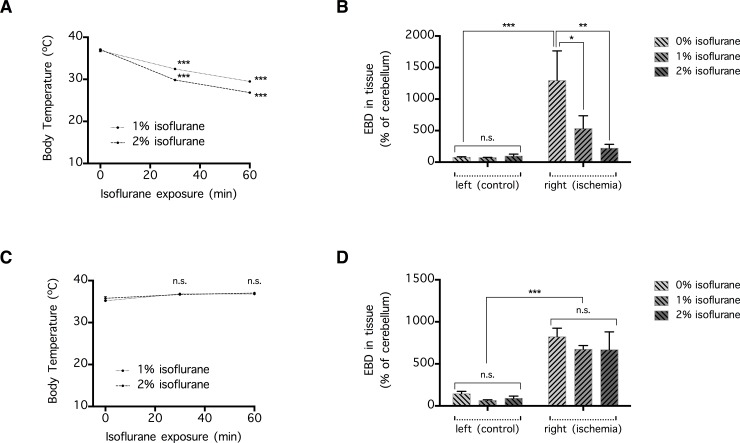
Hypothermic but not normothermic isoflurane-anesthesia attenuates early blood-brain barrier (BBB) disruption following distal middle cerebral arterial occlusion (dMCAo).(A) Body temperature was measured continuously in mice using a rectal probe, and recorded at 0, 30, and 60 min after exposure to 1% or 2% isoflurane (n = 5 per group). Data are expressed as mean ± SEM, and ***p<0.001 indicates a significant change in body temperature over time. (B) To induce ischemic BBB disruption, the mice were subjected to 120 min of dMCAo coupled with ipsilateral common carotid arterial occlusion. At 4 h post-reperfusion (6 h after the onset of ischemia), the mice were placed for 1 h inside a gas chamber filled with 0%, 1%, or 2% isoflurane to induce hypothermia. The severity of BBB disruption was determined by comparing the concentrations of intravascular tracer Evans blue dye (EBD), injected 4 h post-reperfusion and quantified 1 h thereafter, extravasated into the left (control, non-ischemic) and the right (ischemic) hemisphere (n = 13–14 per group). Data are expressed as mean ± SEM. *p<0.05 and ***p<0.001 indicate a significant difference, whereas n.s. indicates no significant difference. (C) Same as (A), except that body temperature was maintained with a heating pad (n = 4 per group). (D) Same as (B), except that body temperature was maintained with a heating pad (n = 4–5 per group).